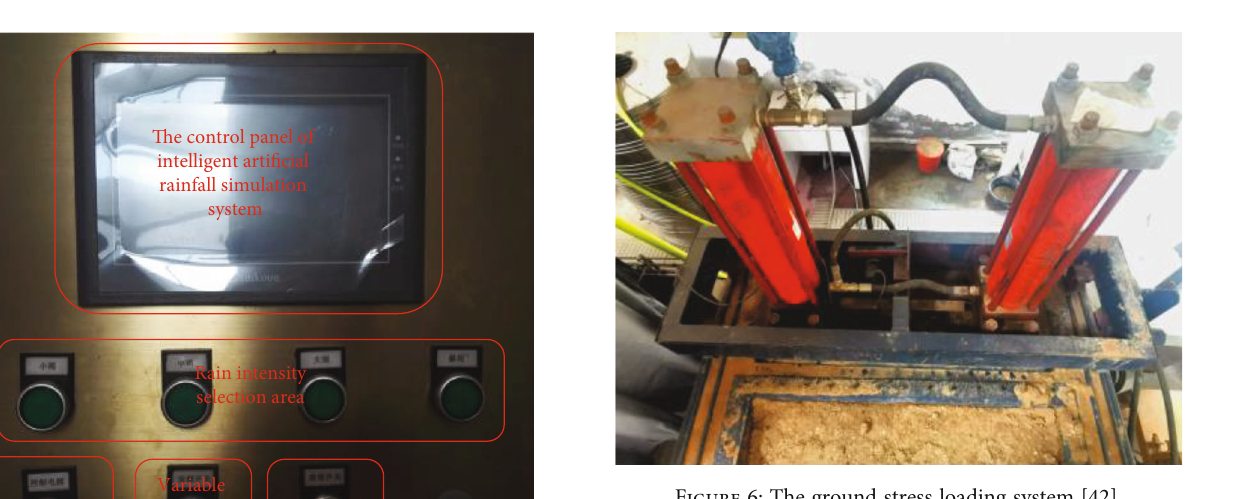
Figure 6: The ground stress loading system [42].